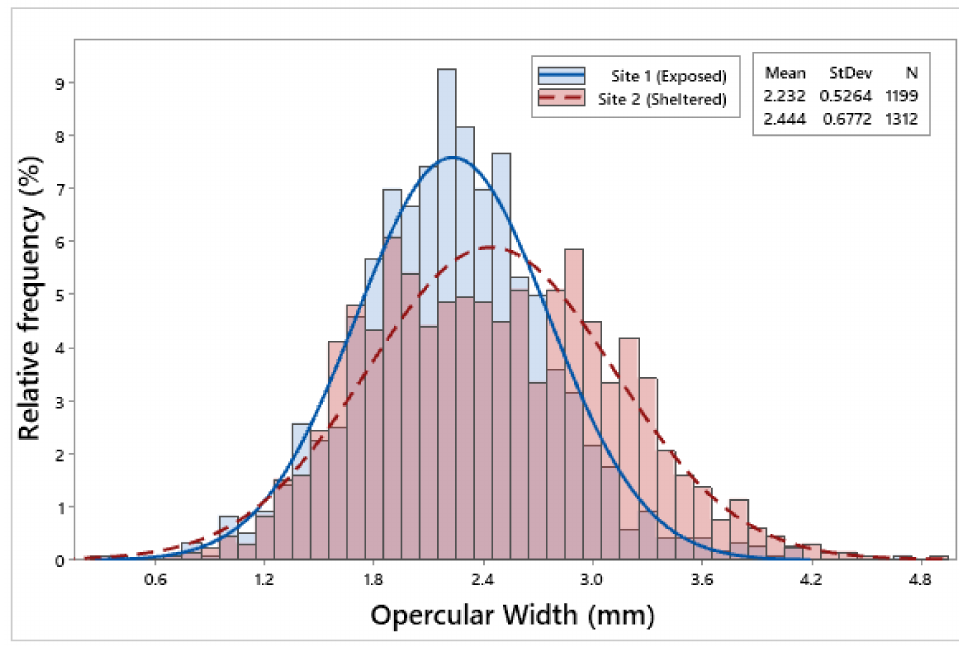
Figure 8. Total opercular width–frequency distribution of C. stellatus populations with overlaid fitted normal distribution at both sampling sites.